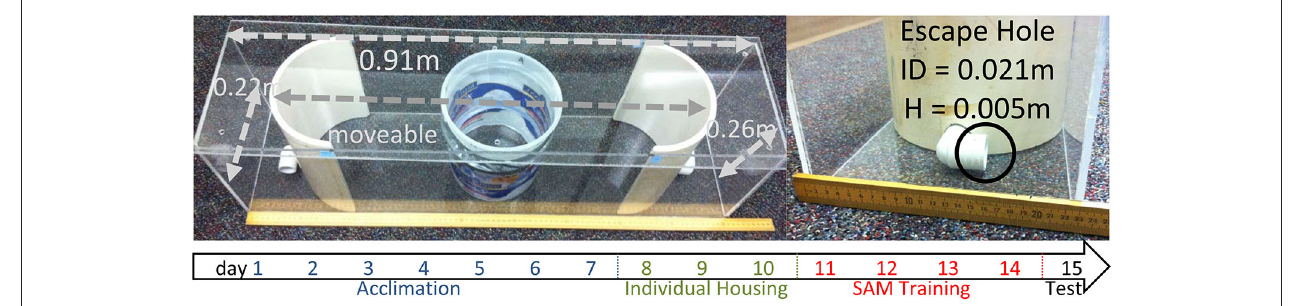
of the hole 0.005 m above the floor. A large CD1 aggressor is placed outside the opaque cylinder, and then a test animal is placed inside an opaque cylinder 30 s prior to social interaction. Below: Time line indicating events (blue: group housing, cage acclimation; green: individual housing; red: social interaction in SAM apparatus; black: testing without aggressor, sampling) for test animals by